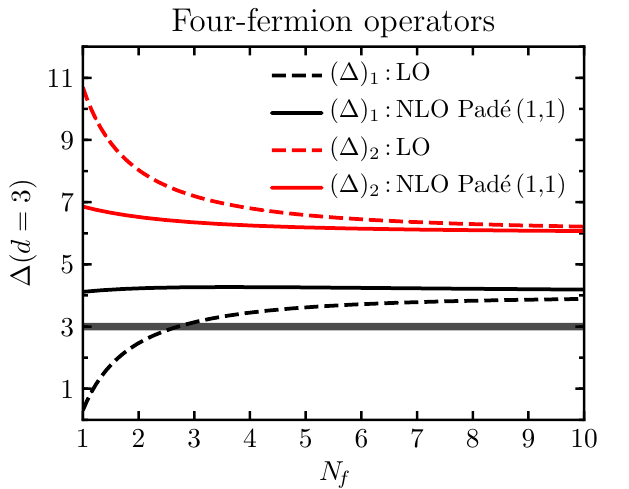
Figure 2 . Extrapolations of the scaling dimensions of the two (cid:13)avor-singlet four-fermion operators to d = 3, as a function of N f . In black (lower two lines) ((cid:1)) 1 and in red (upper two lines) ((cid:1)) 2 . Dashed lines are the LO estimate and solid lines the NLO Pad(cid:19)e (1,1). order (1,1). We list the values of the LO and NLO Pad(cid:19)e (1,1) predictions for the values of N = 1 ; : : : ; 10 in table f